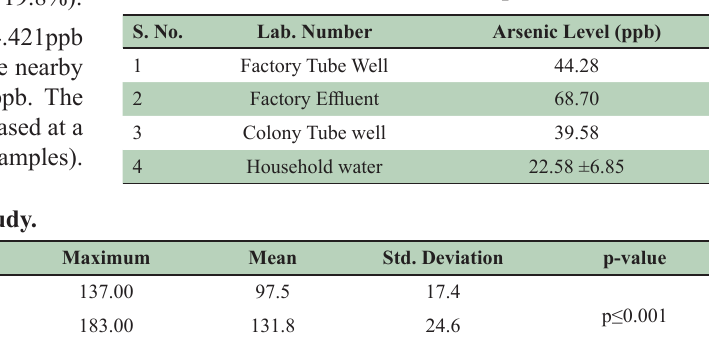
Table-I: Arsenic levels in water samples.